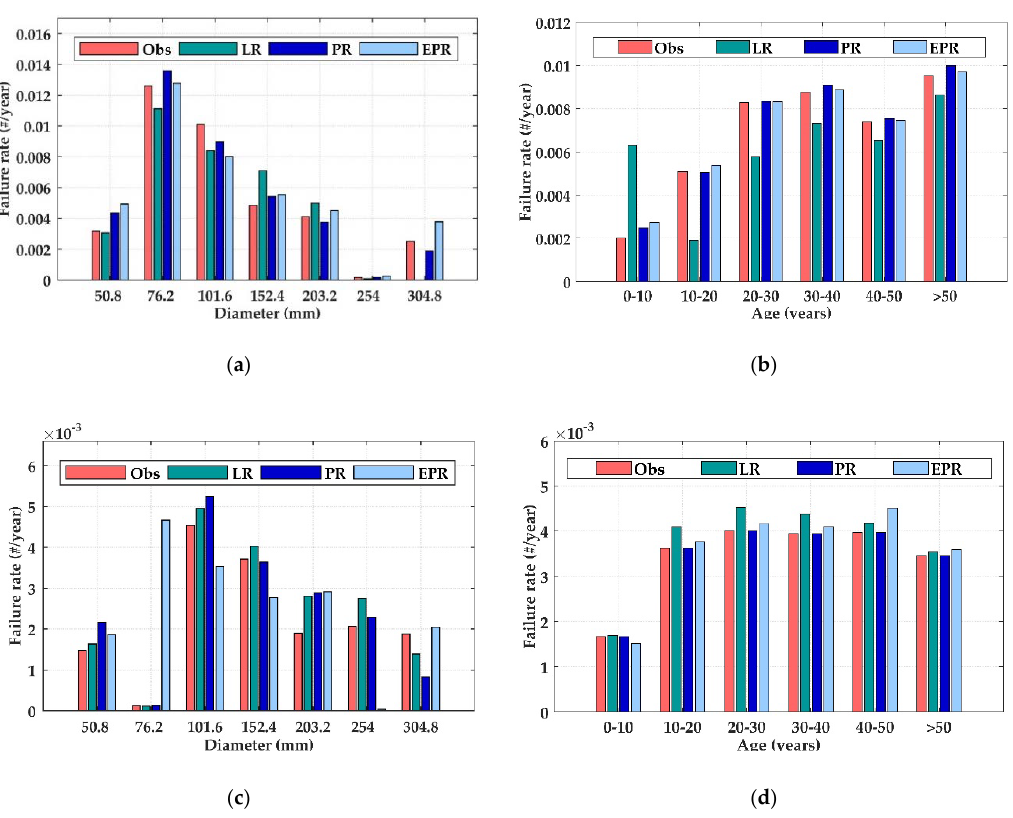
Figure 5. Average observations and predictions of failure rate based on: ( a ) Asbestos-cement pipe diameter; ( b ) Asbestos-cement pipe age; ( c ) PVC pipe diameter; ( d ) PVC pipe age.